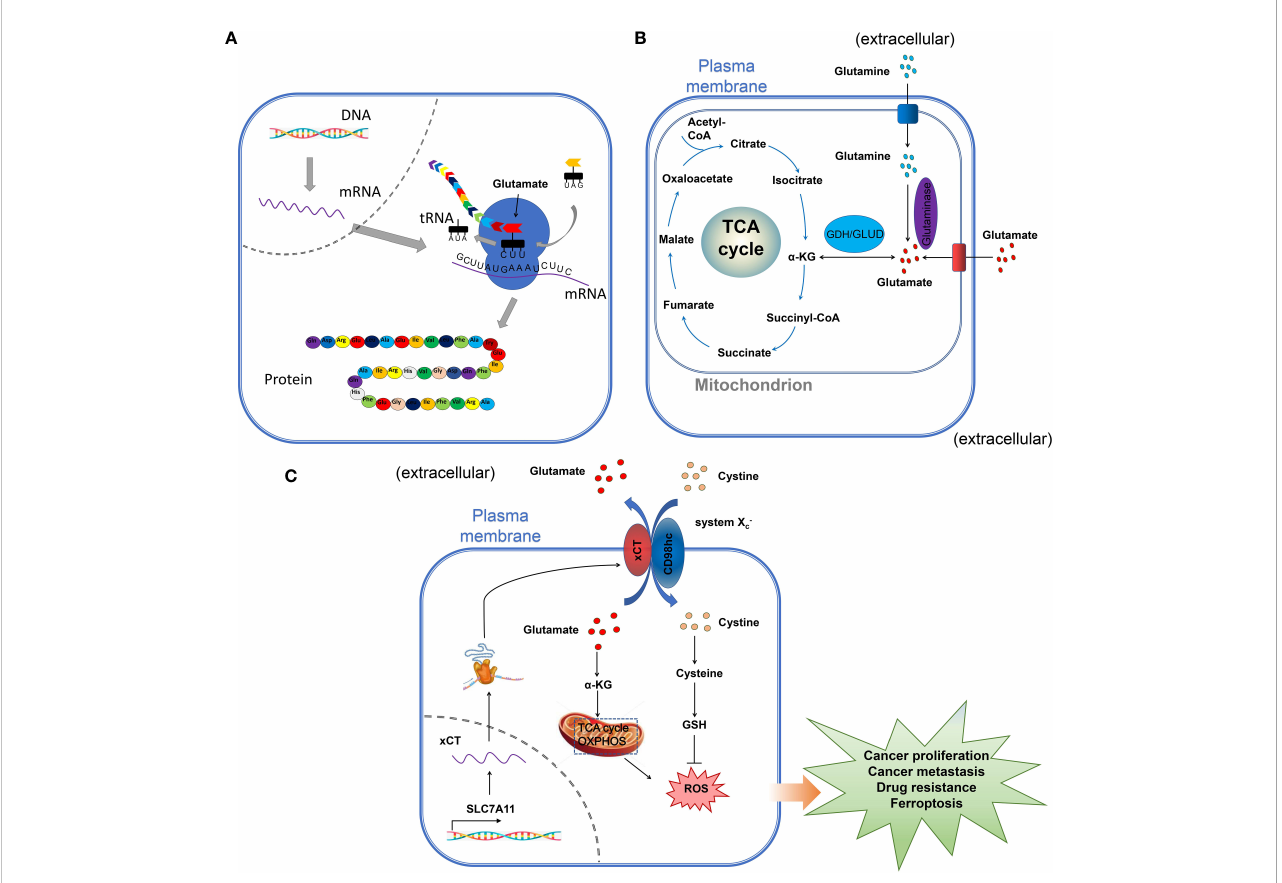
FIGURE 1 The role of glutamate in cells. (A) the role of glutamate in protein synthesis. The amino-acid glutamate is the substrate for protein synthesis, important for the maintenance and promotion of cell function. (B) the role of glutamate in the TCA. Extracellular glutamate is one of the most important sources of carbon in The TCA cycle. In the mitochondria, glutamate is deaminated to a -ketoglutarate ( a -KG) by glutamate dehydrogenase (GDH), which is incorporated in the TCA cycle for energy production. (C) glutamate and the maintenance of cell homeostasis and regulation of cell proliferation. The amino-acid exchangers also known as cystine-glutamate transporter (xCT/SLC7A11), play a very important role in maintaining redox homeostasis by exchanging extracellular cystine in exchange for intracellular glutamate to maintain intracellular redox and the energy production for the regulation of cell